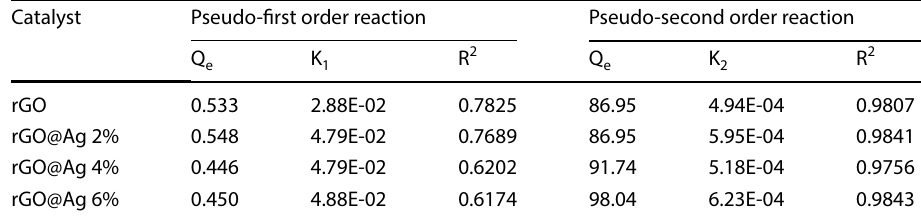
Table 3 The calculated constants of pseudo-first and pseudo-second order reactions for CR dye